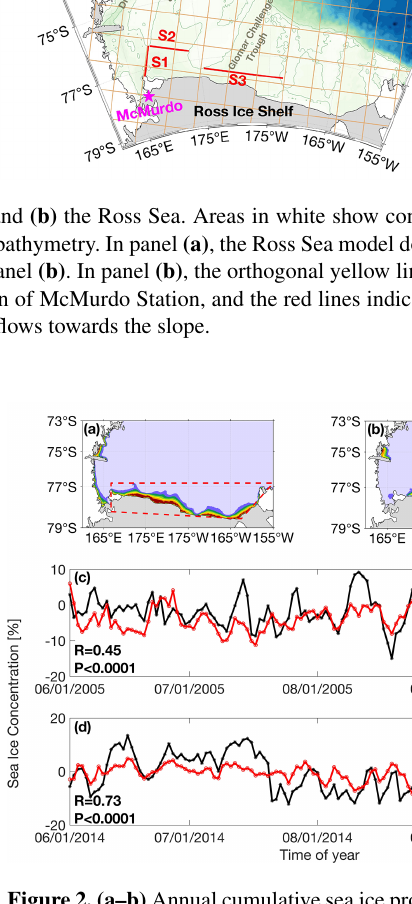
Figure 2. (a–b) Annual cumulative sea ice production rates over the Ross Sea from (a) the Ross Sea model and (b) the AMSR-E prod- uct averaged over 2003–2010. The polygon in panel (a) enclosing the Ross Ice Shelf Polynya was used to analyze the HSSW charac- teristics. (c–d) Time series of observed (black lines) and modeled (red lines) daily polynya-averaged sea ice concentration anomalies in June–September of 2005 and